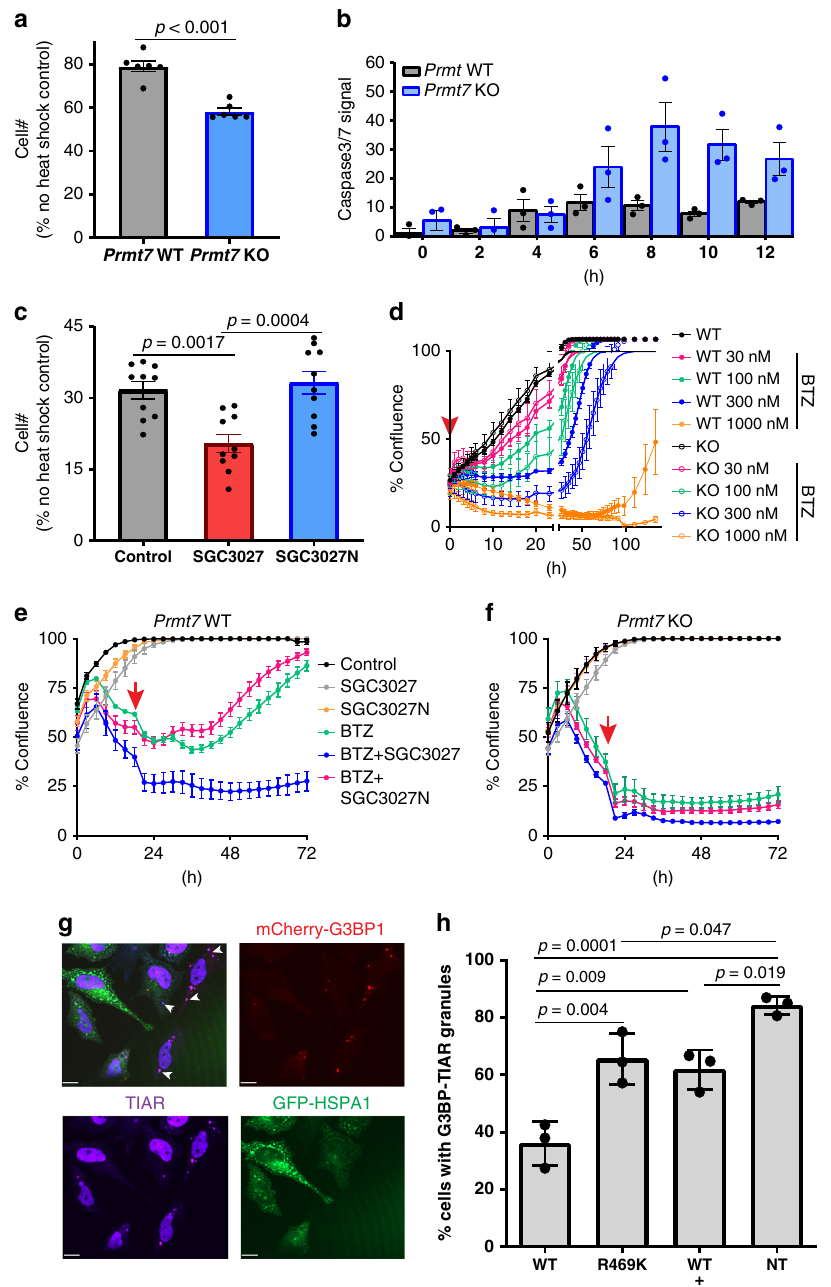
Fig. 6 PRMT7 knockout/inhibition affects cell survival after heat shock or proteasomal stress. a , b Loss of PRMT7 decreases cell survival and increases apoptosis levels after heat shock. MEF cells were heat-shocked for 20 min at 44 °C. Apoptosis was monitored immediately after the heat shock and cell number was determined 24 h later. The results shown are mean ± SEM of two biological replicates, each technical triplicate ( a ) and three technical replicates ( b ). Statistical signi fi cance was determined with unpaired Student t -test (two-tailed). c SGC3027 inhibition of PRMT7 activity decreases cell survival and increases apoptosis levels after heat shock. Cells were pretreated with 3 µ M compounds for 2 days before heat shock. Cell number